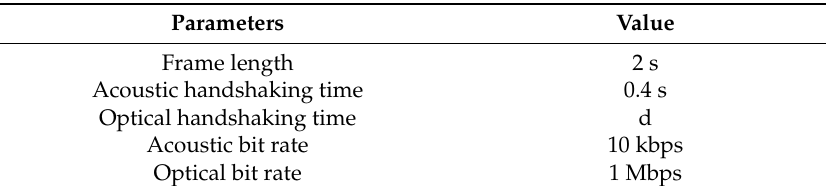
Table 1. Channel simulation parameters.